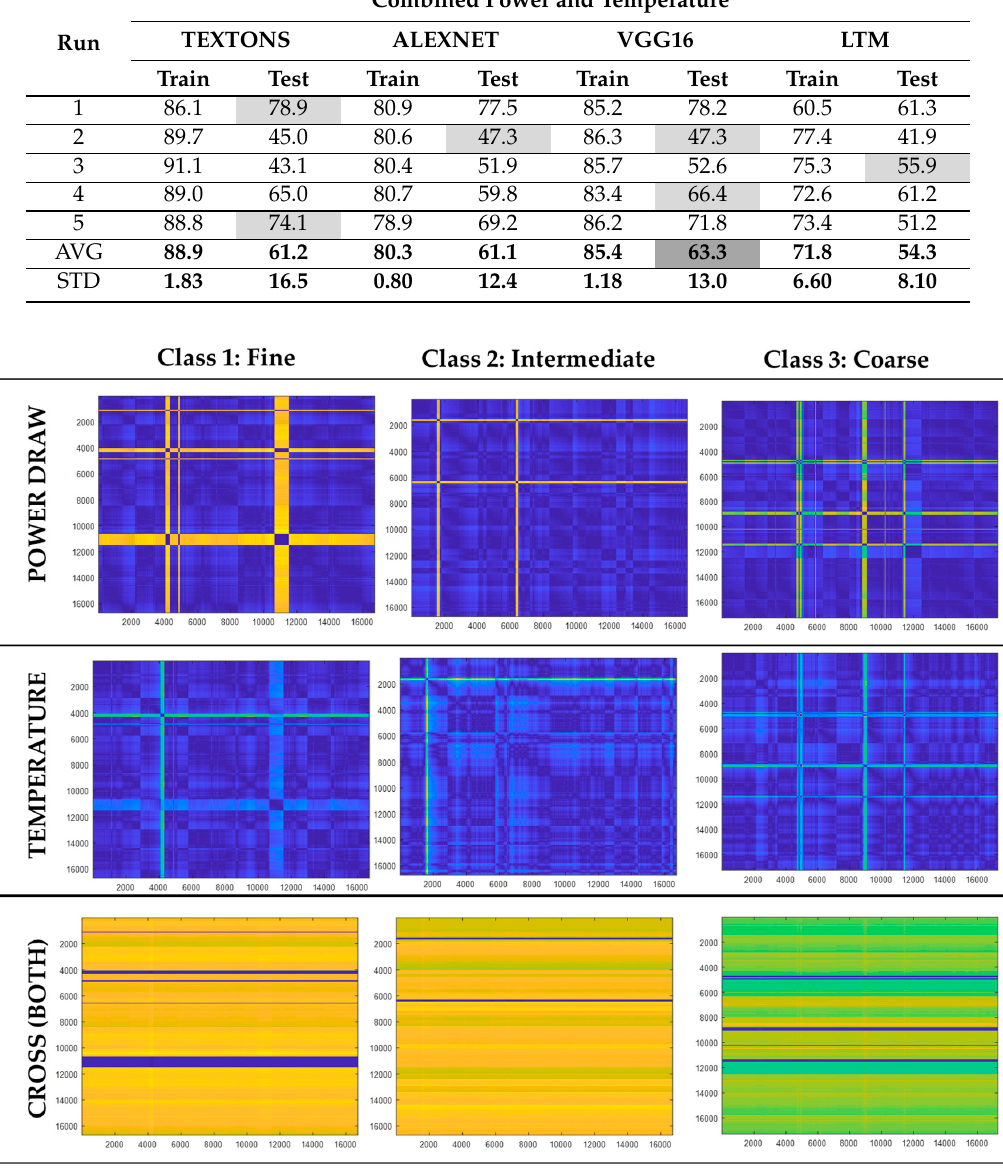
Figure 16. Distance matrix plots of 3 classes—fine (left), intermediate (middle), and coarse (right)—using time series of power draw (top), outlet temperature (middle), and cross distance of these variables (bottom). Small values are indicated by dark blue colors on the one extreme, while large distance values are indicated by bright yellow colors.